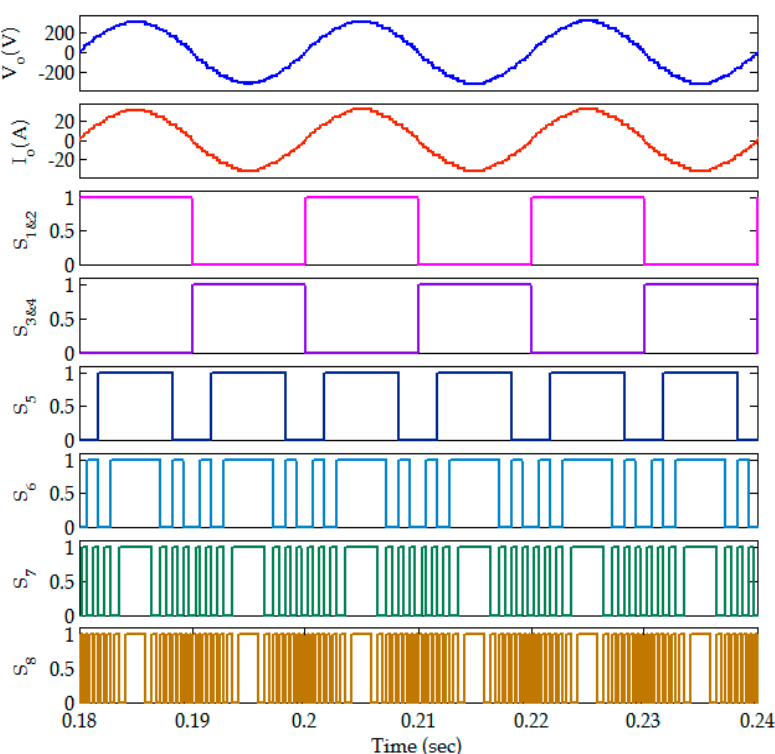
Figure 5. Output waveforms and switching pattern of reduced switch 31 − level MLI.